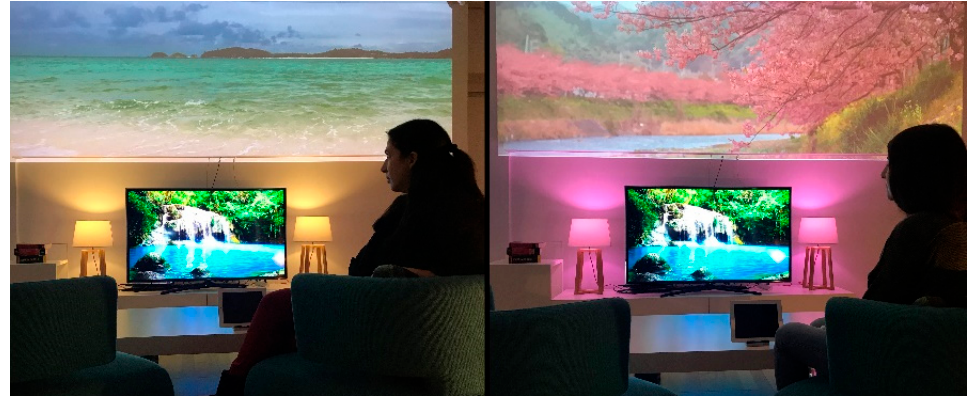
Figure 3. Relaxation technique “Exposure to Nature”, adjusted to user